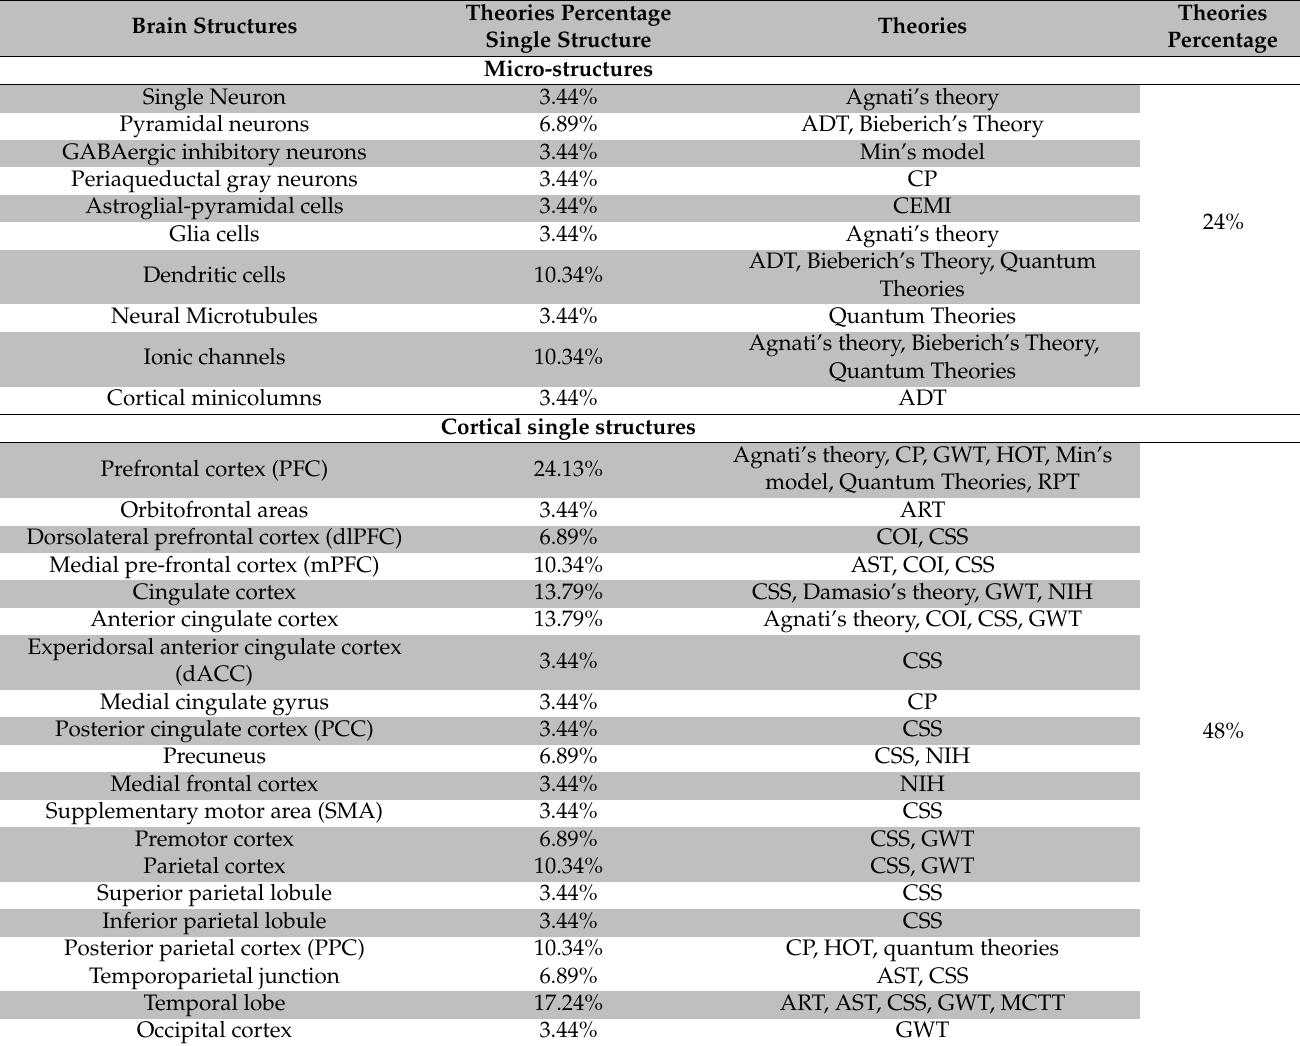
Table 3. Main neural correlates of consciousness reported in the various theories. In the second column, the percentage of theories referring to a specific neural structure is reported. The third column contains the name of theories that were reported for each neural structure. The fourth column indicates the percentage of theories that refer to either micro-, subcortical-, cortical-structures, or entire systems as neural correlates of consciousness. Theories Percentage Theories Brain Structures Theories Single Structure Percentage